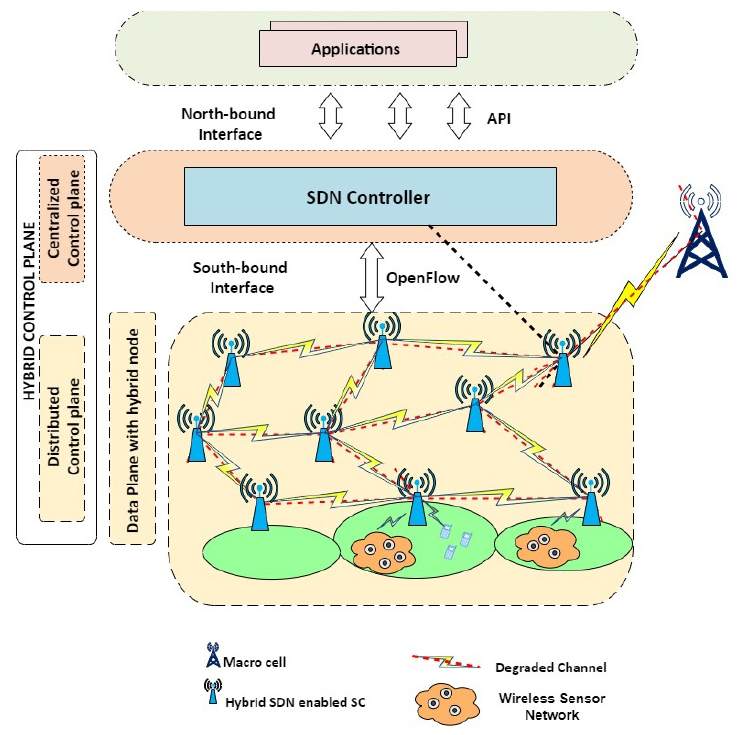
Figure 1. The proposed hybrid control plane architecture for